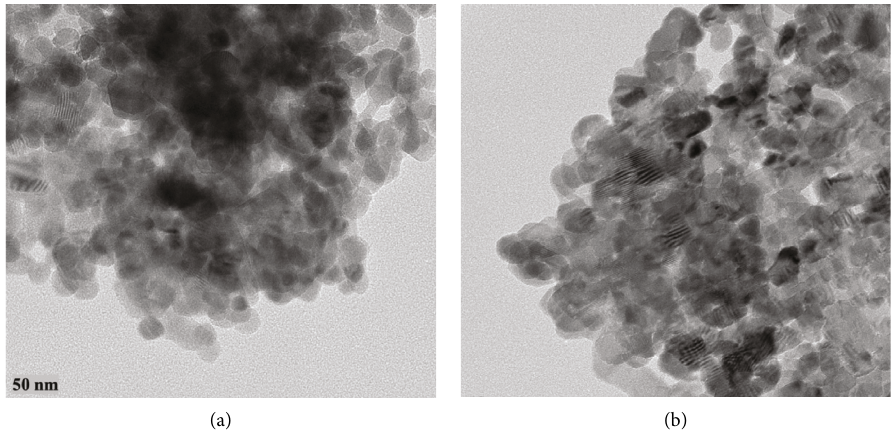
Figure 4: Transmission electron microscopy (TEM) images of (a) zinc oxide nanoparticles (ZnONPs) and (b) plant-fabricated zinc oxide nanoparticles (PF-ZnONPs), magnified at the accelerating voltage of 200KV, camera length of 520mm, and electron wavelength of 0.0251 (Figure 8(a)). The removal efficiency of PF-ZnONPs dropped to 67.61% and that of ZnONPs dropped to 66.92%